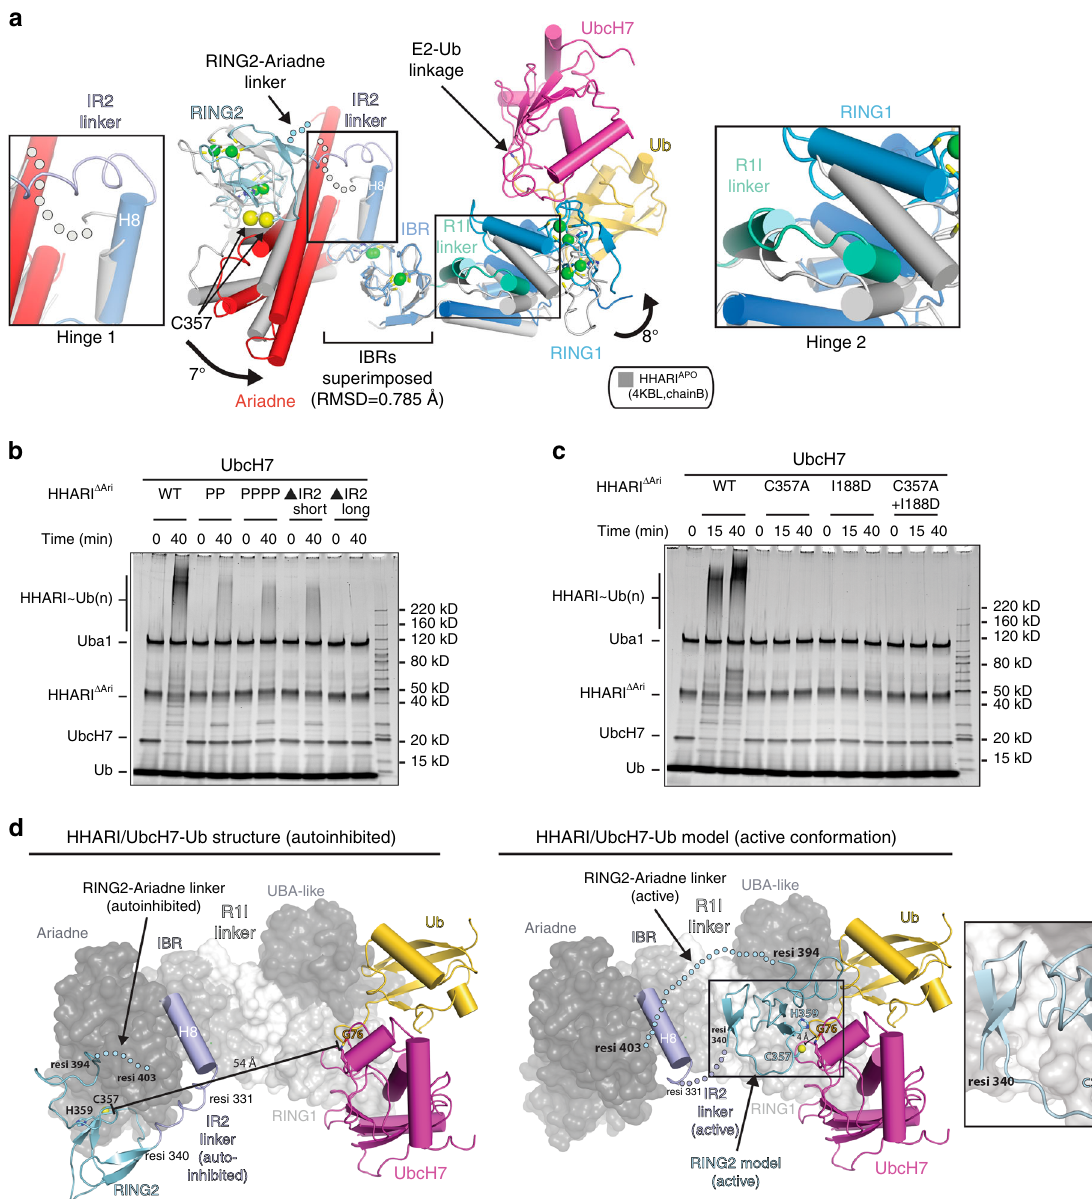
Fig. 7 Modeling conformational changes accompanying thioester transfer of Ub from E2 to HHARI. a Comparison of apo and E2 bound HHARI reveal conformational changes in the IR2/RING2 region. The IBR domains of apo HHARI (PDB: 4KBL, chain B) and E2 bound HHARI were superimposed and the structures are shown as cartoon representations. The hinge 1 and hinge 2 regions are boxed and magni fi ed views are shown to the left and right of the structure, respectively. Bold black arrows indicate the direction of the rotation resulting from conformational changes in hinges 1 and 2. Disordered linkers connecting the IBR and RING2 domain and the RING2 and Ariadne domains are shown as semitransparent spheres . b Structure-function analysis of the HHARI IR2 linker. WT, mutant HHARI Δ Ari proteins were used in HHARI autoubiquitination assays for the indicated time points, as described in the Methods. “ PP ” refers to T333P/S334P HHARI double mutant. “ PPPP ” refers to T333P/S334P/A338P/A339P HHARI quaternary mutant. “ Δ IR2 short ” and “ Δ IR2 long ” refer to Δ 333 – 339 and Δ 322 – 339 HHARI deletion mutants, respectively. c Evaluation of cis vs. trans mechanisms for HHARI activation. The indicated HHARI Δ Ari variants were subjected to autoubiquitination assays with UchH7 for the indicated time points, as described in the Methods. d ( left ) The HHARI/UbcH7-Ub structure with Ub(t) ( gold ), UbcH7 ( magenta ), and the HHARI IR2 linker ( slate ) and RING2 domain ( light blue ) shown as cartoon representations. Other HHARI domains are shown as a transparent surface representation. The disordered region linking the RING2 and Ariadne domains is shown as semitransparent light blue spheres . ( right ) A model of an ‘ active ’ HHARI/UbcH7-Ub complex was created using the structure of the HOIP/UbcH5b-Ub complex (PDB:5EDV) as a guide. The hypothetical conformational changes of the HHARI IR2 and RING2-Ariadne linkers required for the RING2 and UbcH7 domains to come in proximity during thioester transfer are indicated with semitransparent slate colored spheres. The RING2/UbcH7 interface is boxed with a magni fi ed view shown in the